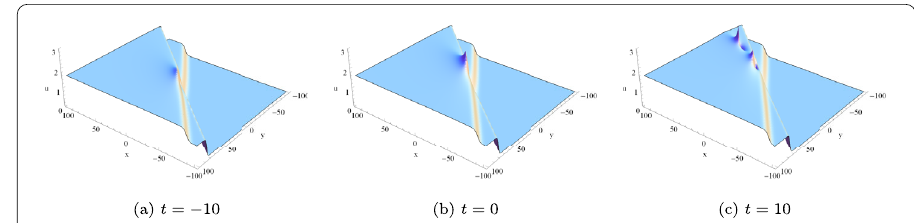
Figure 4 Plot of two lumps and two kink solitons fission with parameters p